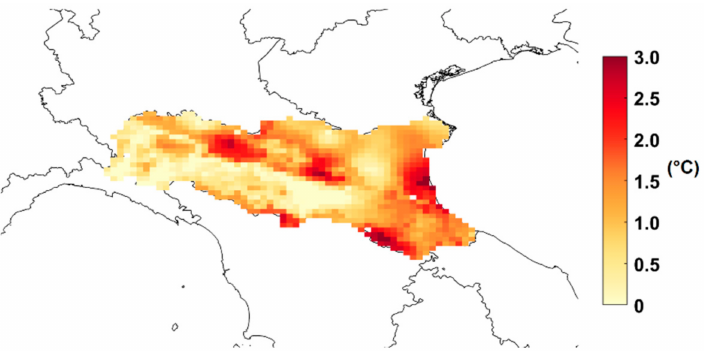
Figure 15. Factors of change for T min,k for the time window 1981–2020 in comparison with the reference time interval 1961–2000.